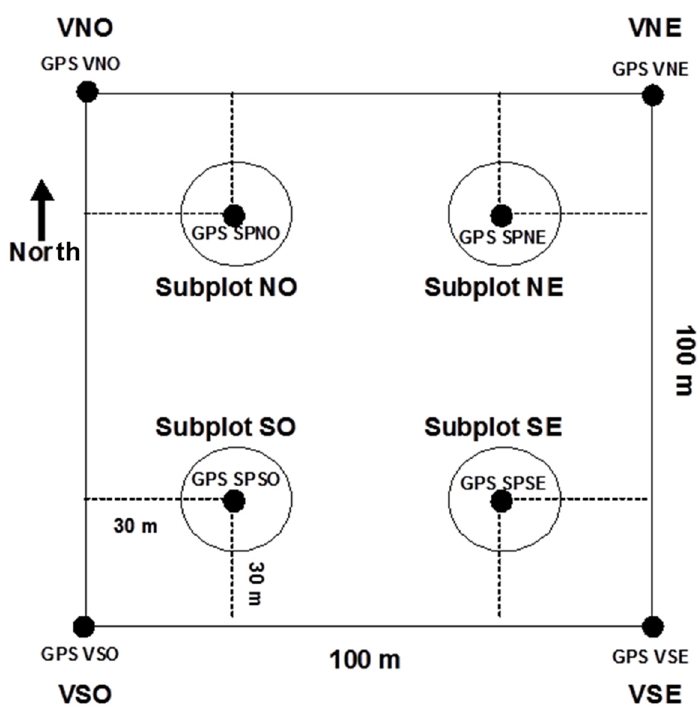
Figure 2. Sampling design of the experimental plot on the Nature Reserve.